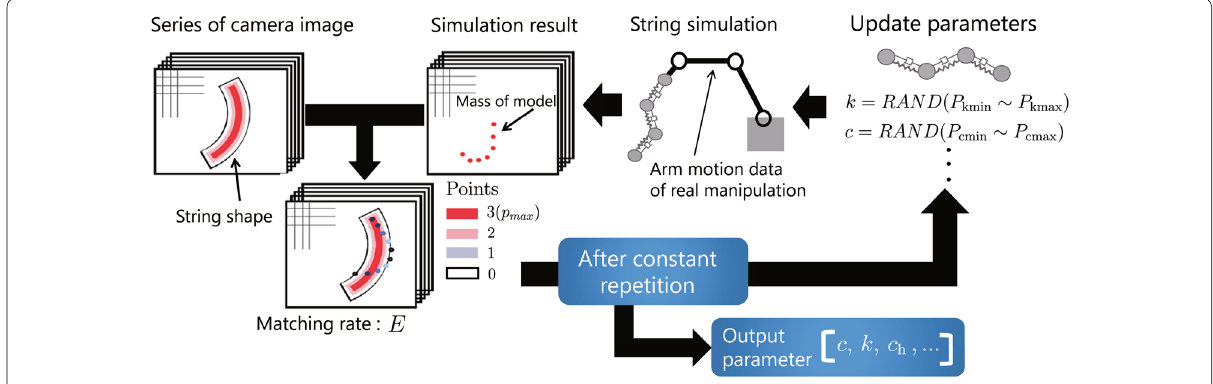
Fig. 5 How to estimate parameters of